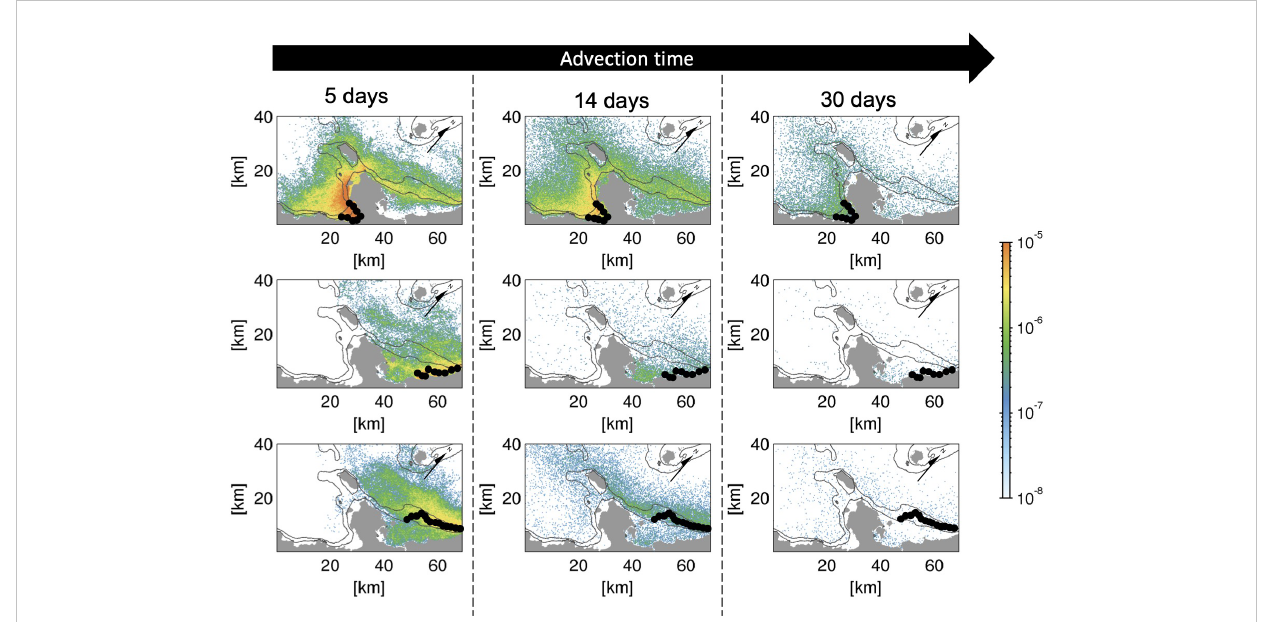
FIGURE 4 Temporal evolution of depth-integrated horizontal Lagrangian PDFs (color) released from (top) areas s2, (middle) s6, and (bottom) m5 at the labeled advection time T a (days). Black circles indicate the source patches of each release area. The black solid contours are the isobaths of 30 and 100 m depths. Arrows point to the true north as the panels are rotated relative to the geographical